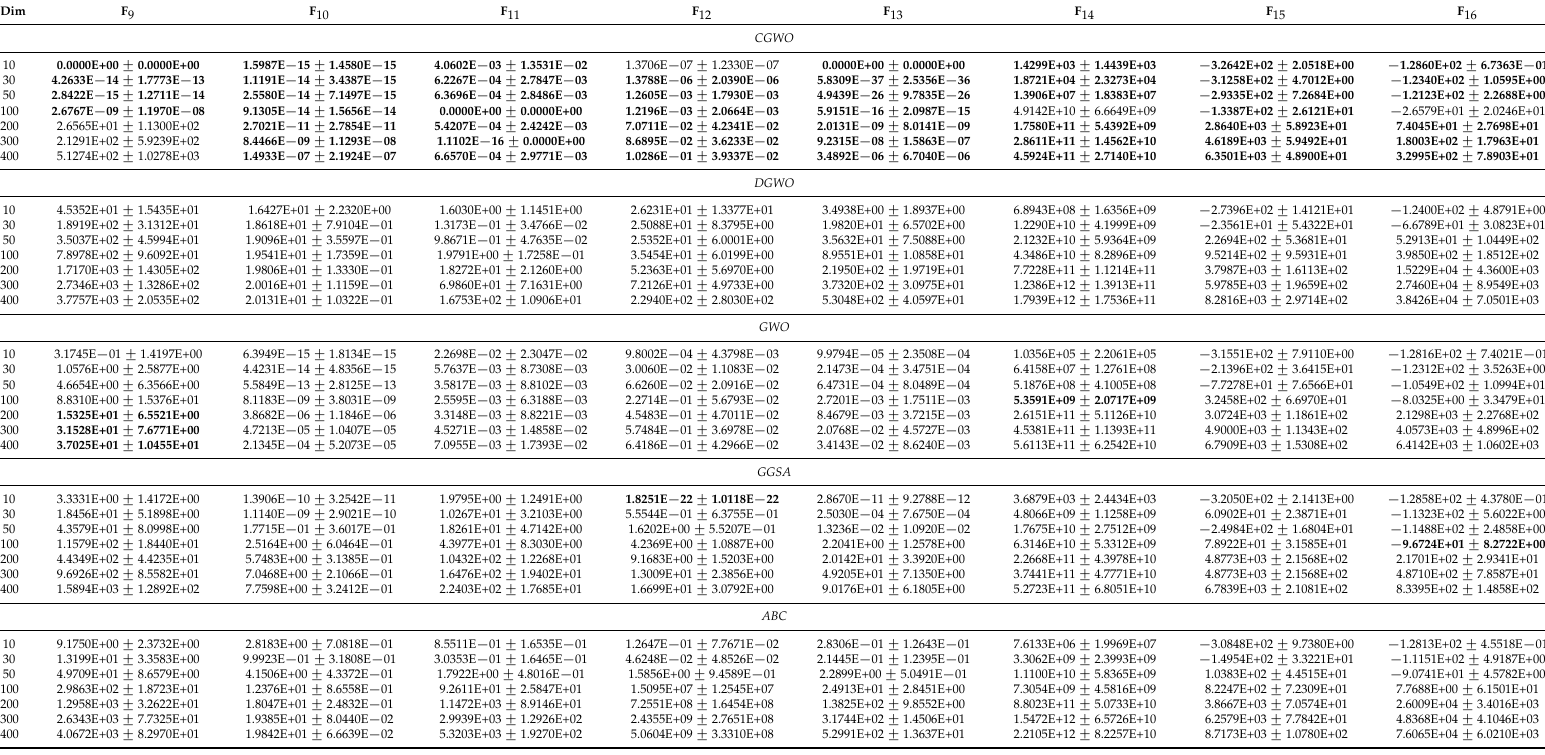
Table 5. Minimization results of the multimodal benchmark